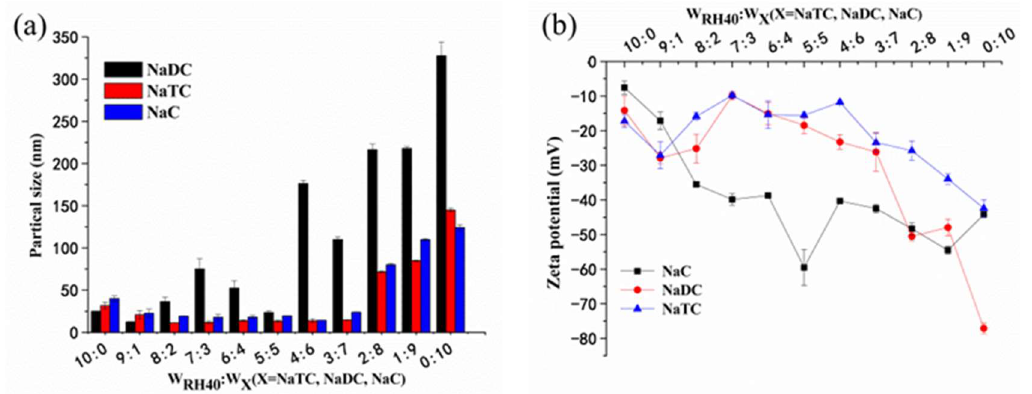
Figure 1. ( a ) Particle sizes and ( b ) zeta potentials of blank self-microemulsifying drug-delivery systems (SMEDDS) after being replaced with Cremophor RH 40 using bile salts (sodium deoxycholate (NaDC), sodium taurocholate (NaTC), or sodium cholate (NaC)) at different mass proportions of the mixed emulsifiers (mean ± SD, n = 3).